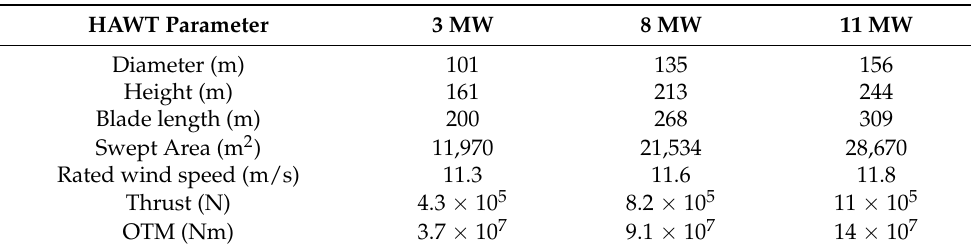
Table A2. Darrieus turbine specifications (Here, blade length is half the circumference of an ellipse with the height provided on the table).